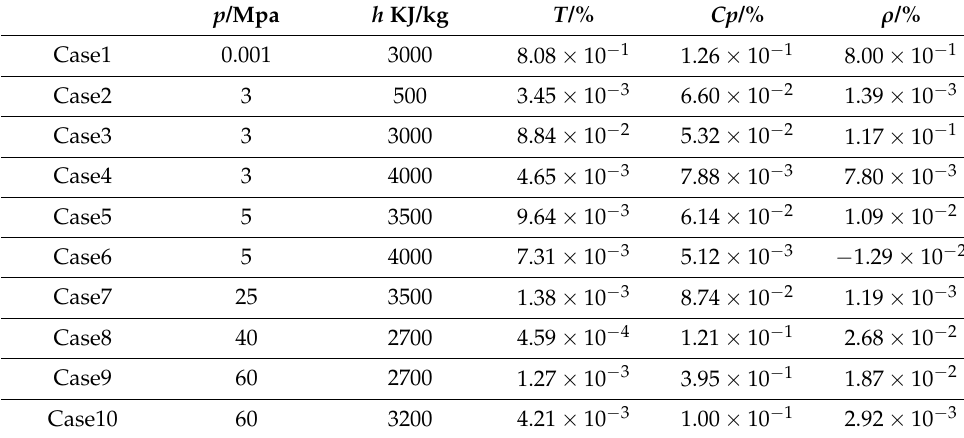
Table 6. The relative error in f ( p , h ) compared with